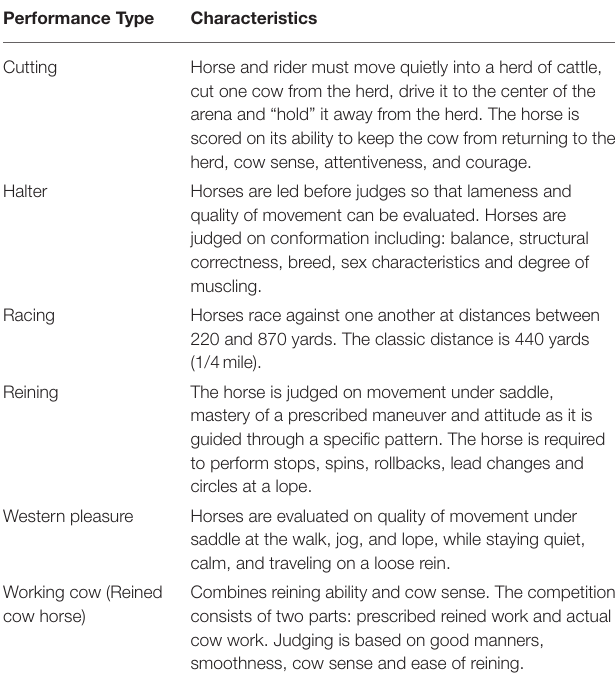
TABLE 1 | Primary characteristics of the six QH performance groups evaluated in this study, as described by the American Quarter Horse Association. Performance